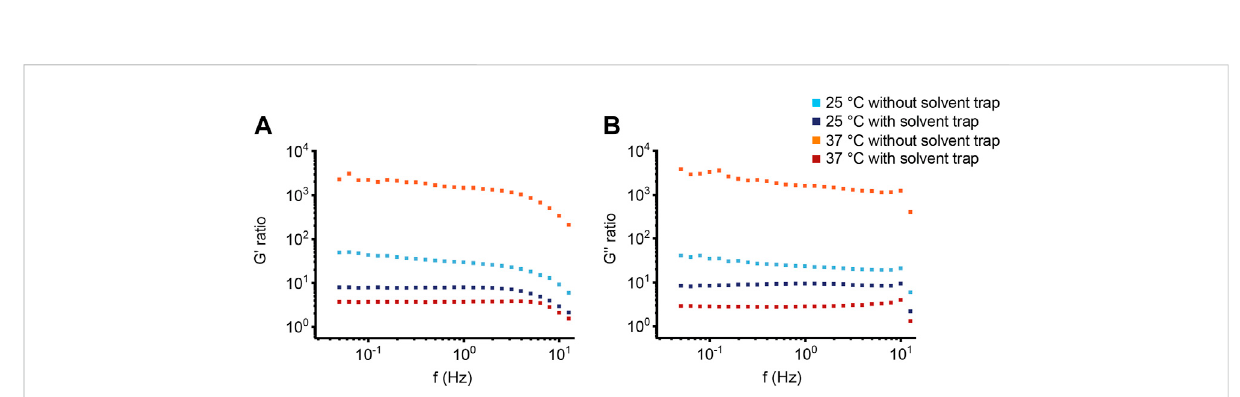
FIGURE 6 Differences in sputum viscoelasticity between healthy individuals and patients in cystic fi brosis. Ratio of (A) the storage modulus G ′ and (B) the loss modulus G ″ betweensputum from patients with cystic fi brosis( n = 10) and sputum from healthy controls ( n = 10) of measurements at25 ° C and 37 ° C with and without solvent